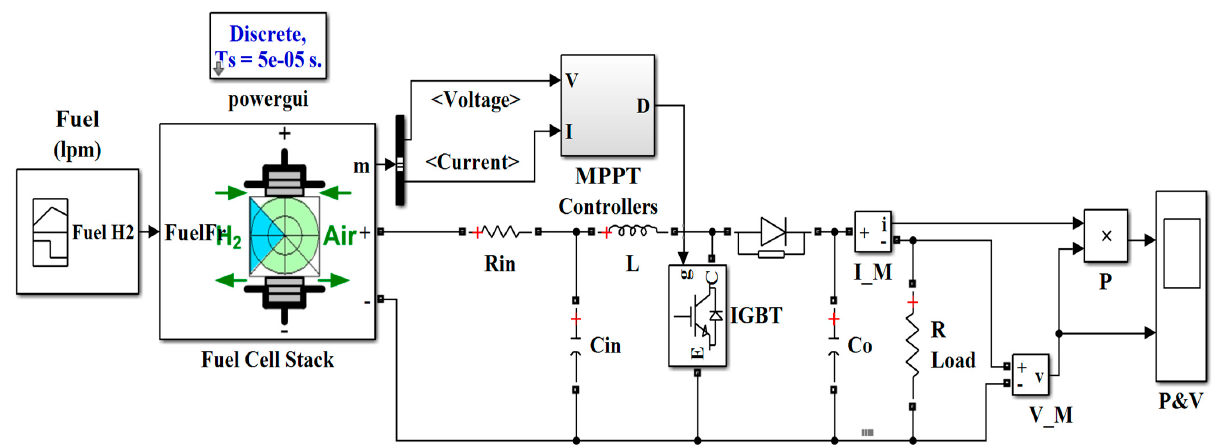
Figure 14. Simulation model of FC system with MPPT controller.